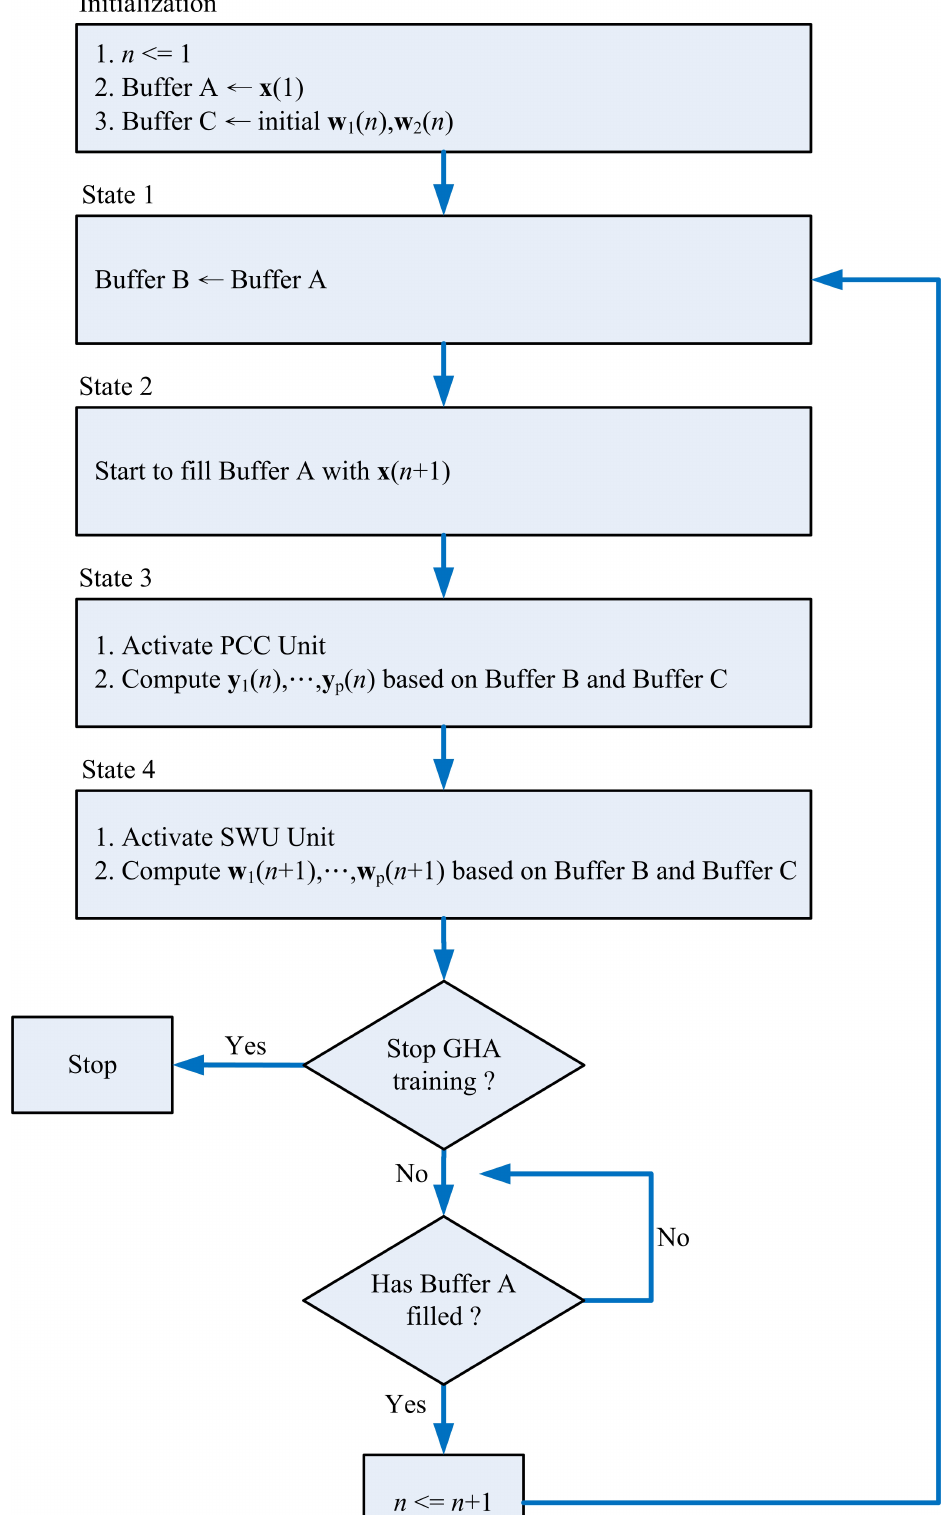
Figure 5. The training operations of the GHA